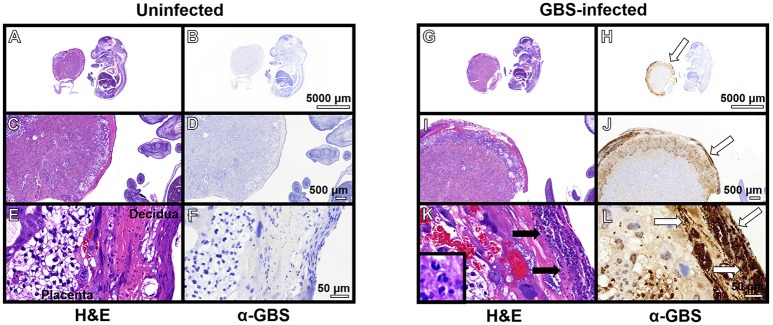
Immunopathological analyses of fetal-placental units. Hematoxylin and eosin (H&E) stained samples of uninfected (A–F) and GBS-infected (G–L) fetal-placental units reveal profound infiltration of polymorphonuclear cells in response to infection (K, black arrows), a result that was not observed in uninfected animals (E). IHC analyses using a polyclonal rabbit antibody to total GBS cell lysate (α-GBS) indicate GBS penetrates the decidua and the placenta to invade the gestational tissues (H,J,L, white arrows), a result that was not seen in uninfected animals (B,D,F). GBS staining is found within tissue compartments containing polymorphonuclear cell infiltrates indicating neutrophils are present at the site of infection (representative images of N = 3–5).